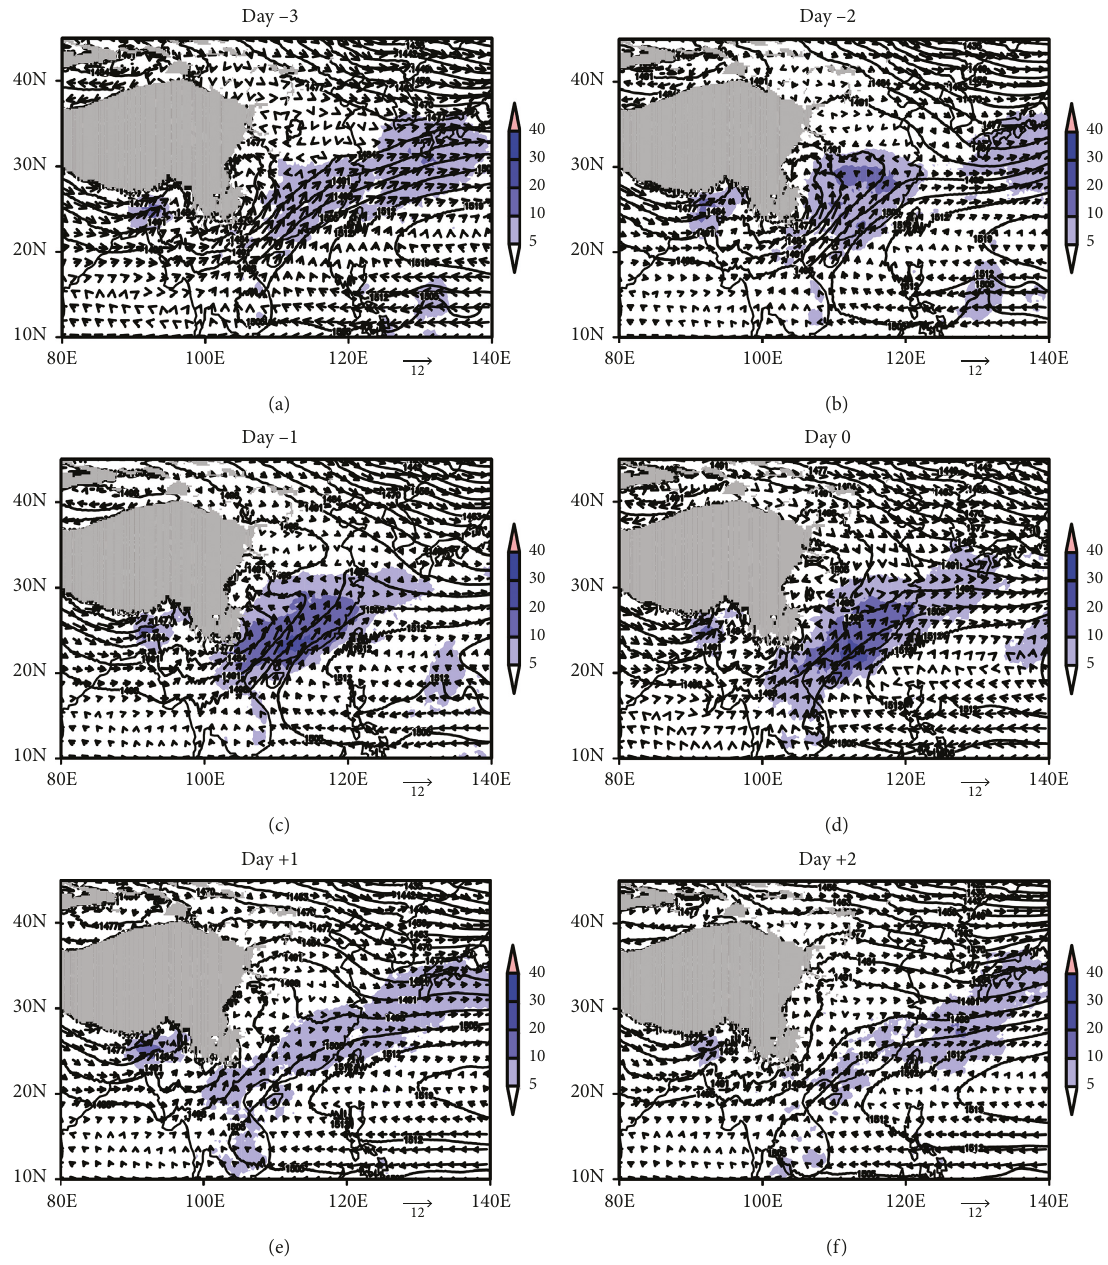
Figure 6: Composite of 850hPa wind ( vector , ms − 1 ), geopotential height ( contour , m), and PERSIANN rainfall ( shaded , mm day − 1 ) during the events associated with cold surge and low-level vortex. The areas where the land elevation is higher than 1500m are shaded